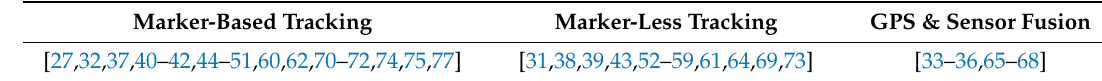
Figure 3. The categories of research areas, research purposes, methods, and data types in AR-based engineering analysis and simulation. Table 7. Tracking methods in selected studies.